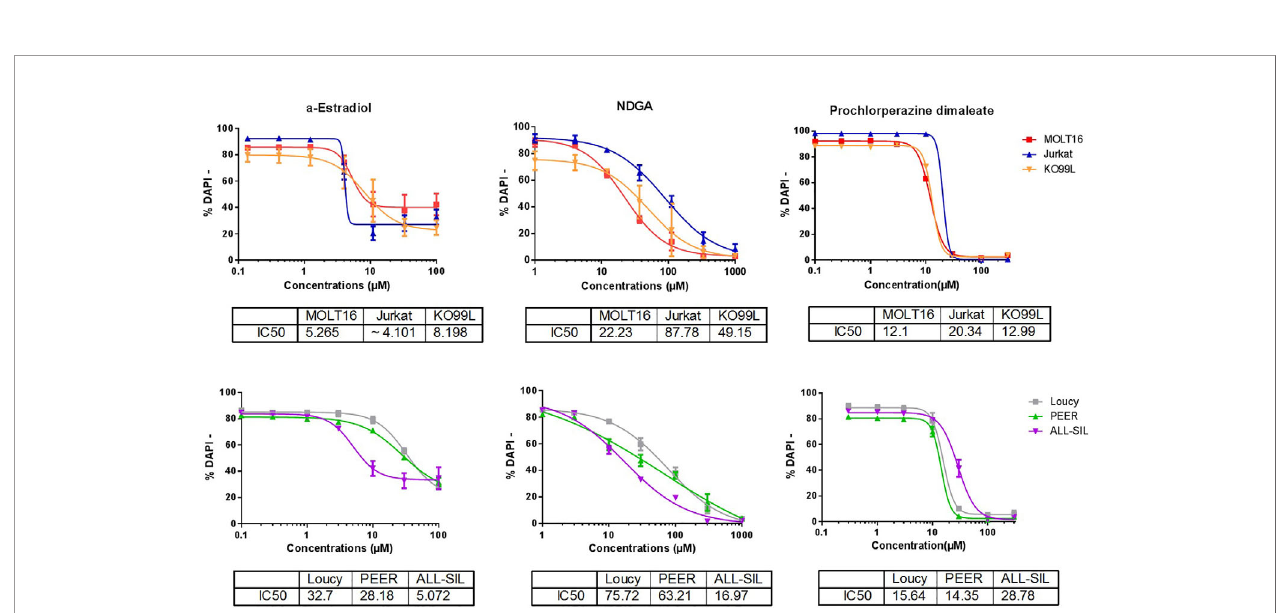
FIGURE 5 | a -Estradiol, Nordihydroguaiaretic acid, and Prochlorperazine induce cell death in T-cell Acute Lymphoblastic Leukemia (T-ALL) cell lines. The effects of the three molecules were analyzed after a 48 h treatment of fi ve human T-ALL cell lines: MOLT-16, Jurkat, LOUCY, PEER, ALL-SIL, and one murine line: KO99L. T- ALL cell viability was measured by fl ow cytometry after DAPI staining. The IC 50 for each drug on the different cell lines are displayed in µM below each panel. The Figure represents the merge of three independent experiments. Results are presented as mean ± SD.